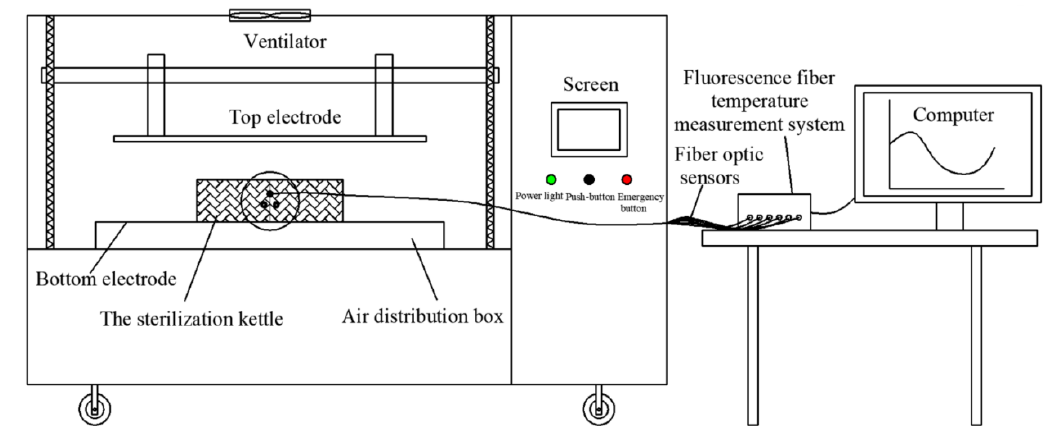
Figure 1. Simplified schematic diagram of sterilization kettle in the RF heating system.